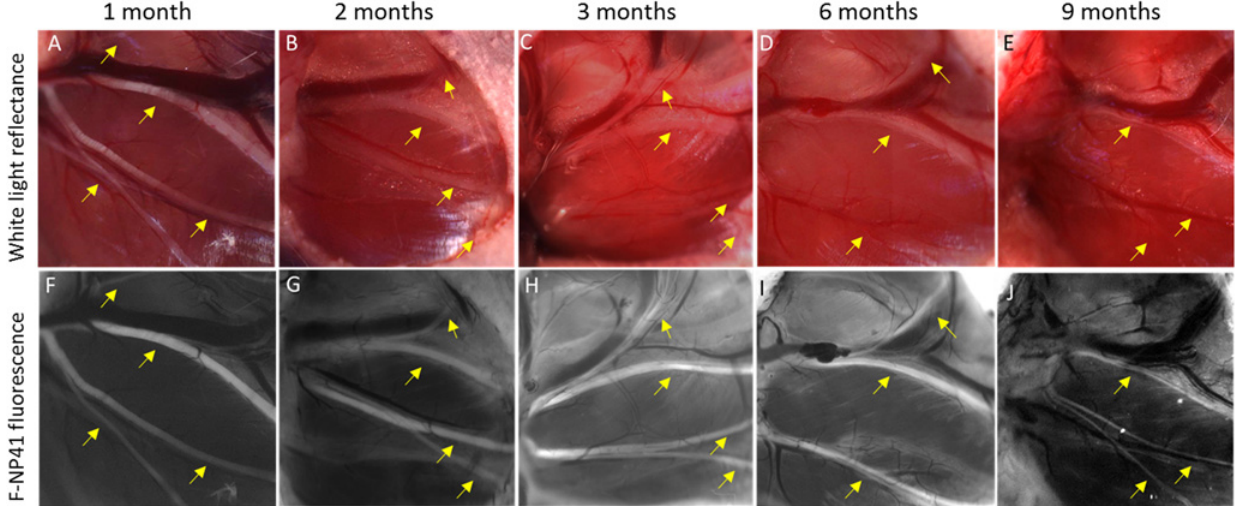
Fig 1. Improved visualization of degenerated facial nerve branches with F-NP41 labeling compared to white light reflectance alone. Yellow arrows in all images pointing to facial nerve branches. A. WL image of intact facial nerve branches. B – E. Facial nerve branches one, two, three and nine months after